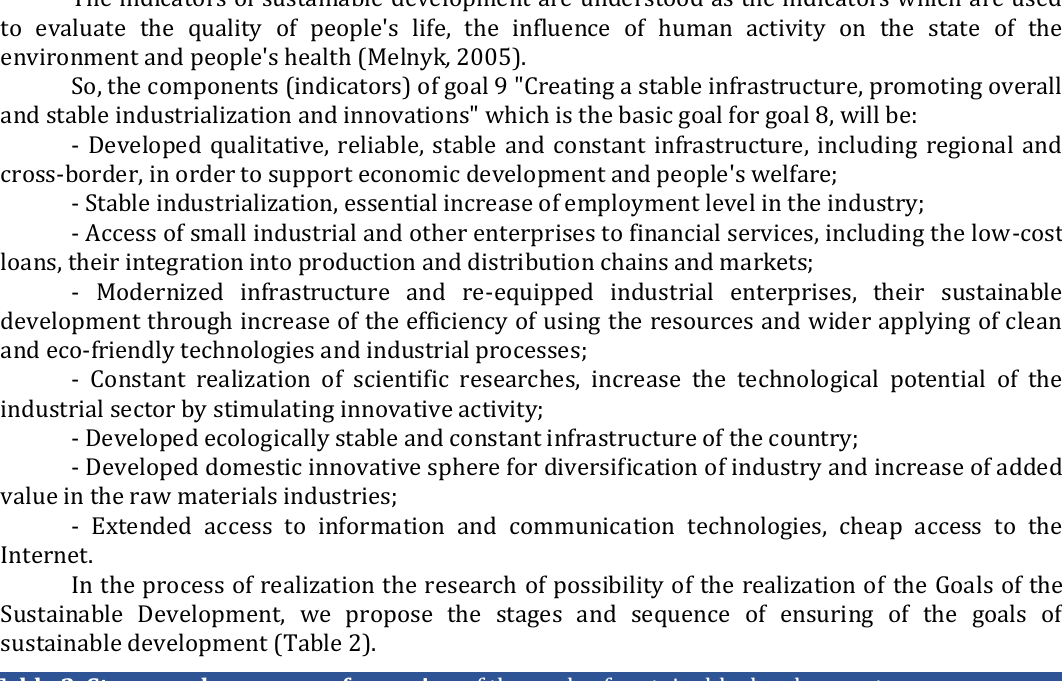
Table 2. Stages and sequence of ensuring of the goals of sustainable development Goals